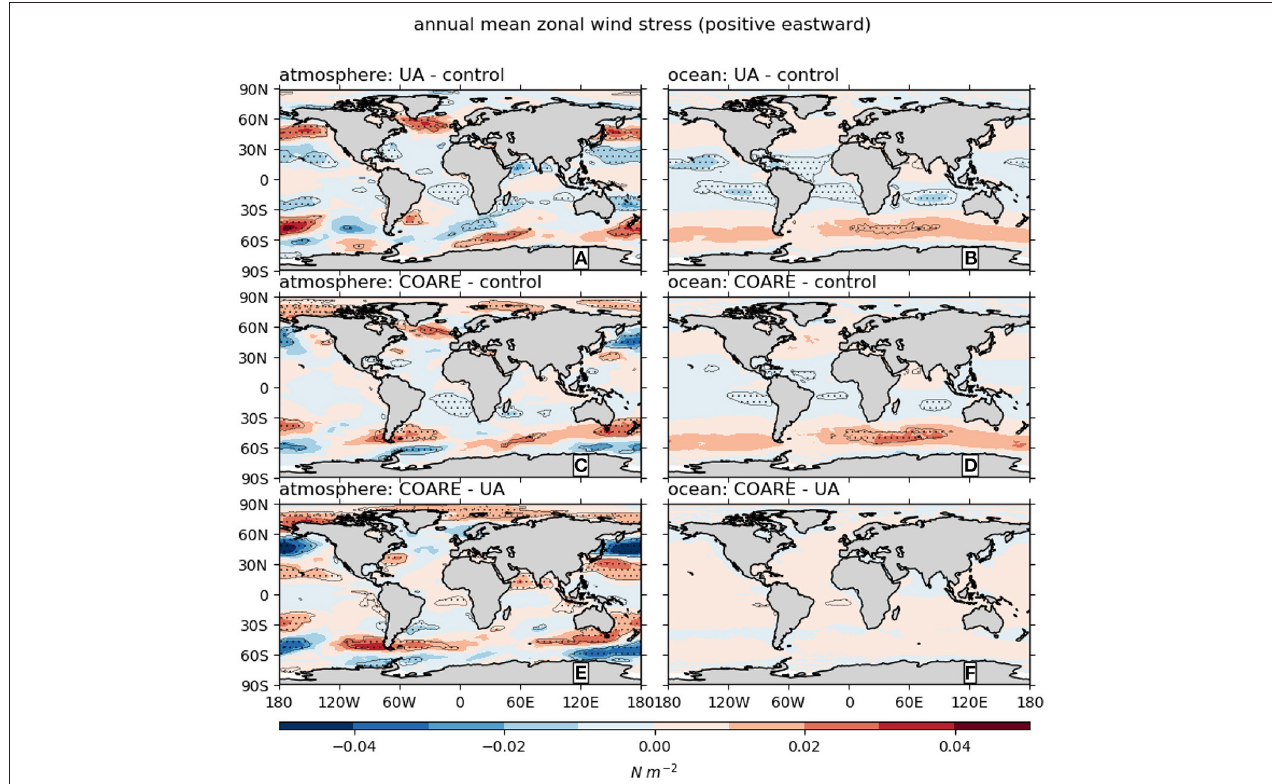
FIGURE 4 | Differences in annual mean zonal wind stress climatology between simulations with different bulk flux algorithms. The atmosphere and ocean simulation results are shown in left and right panels, respectively. Stippling designates regions where the absolute value of the difference is larger than the interannual standard deviation from the E3SMv1 pre-industrial control